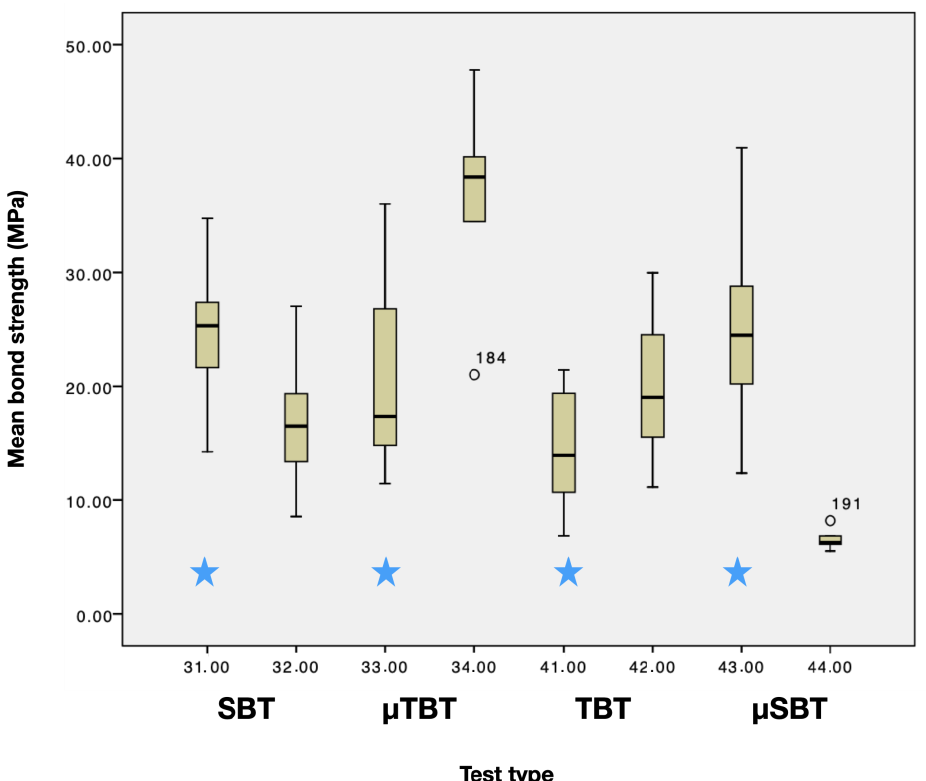
Figure 3. Boxplot of mean bond strength values for different test methods of composite–composite ( ) and ceramic–composite assemblies.